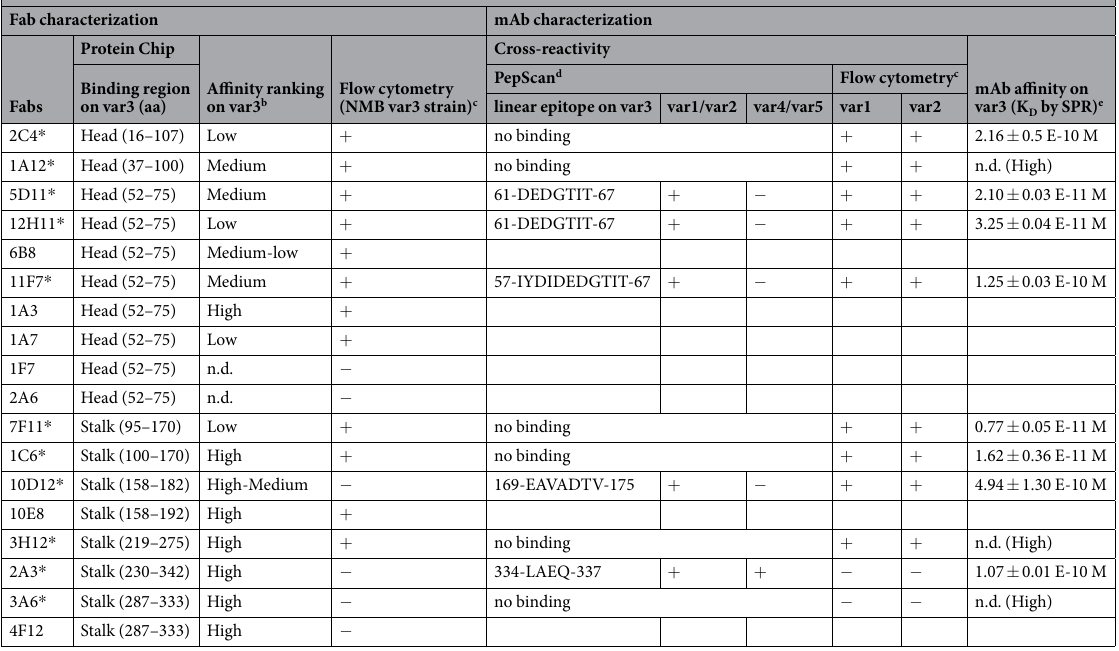
the average hSBA titers elicited by any other mAb. In contrast, mAb 7F11, which binds an overlapping epitope (95–170) is hSBA negative (Fig. 5a). A significant synergistic activity was observed when two anti-head mAbs were combined (Fig. 5b). In contrast, when combinations including the highly bactericidal mAb 1C6 were tested, no synergy could be measured, possibly because the response was already at the plateau. Interestingly, the combi- nation of the stalk-binding mAb 3H12 with mAbs targeting the head domain (2C4 and 5D11) elicited high hSBA titers, whereas a combination of this mAb with other mAbs targeting the stalk gave different results: synergy with mAb 7F11 and interference with mAb 10D12 (Fig. 5b). Similarly to fHbp and NHBA, also in this case synergistic activity was observed between mAbs that were iso-